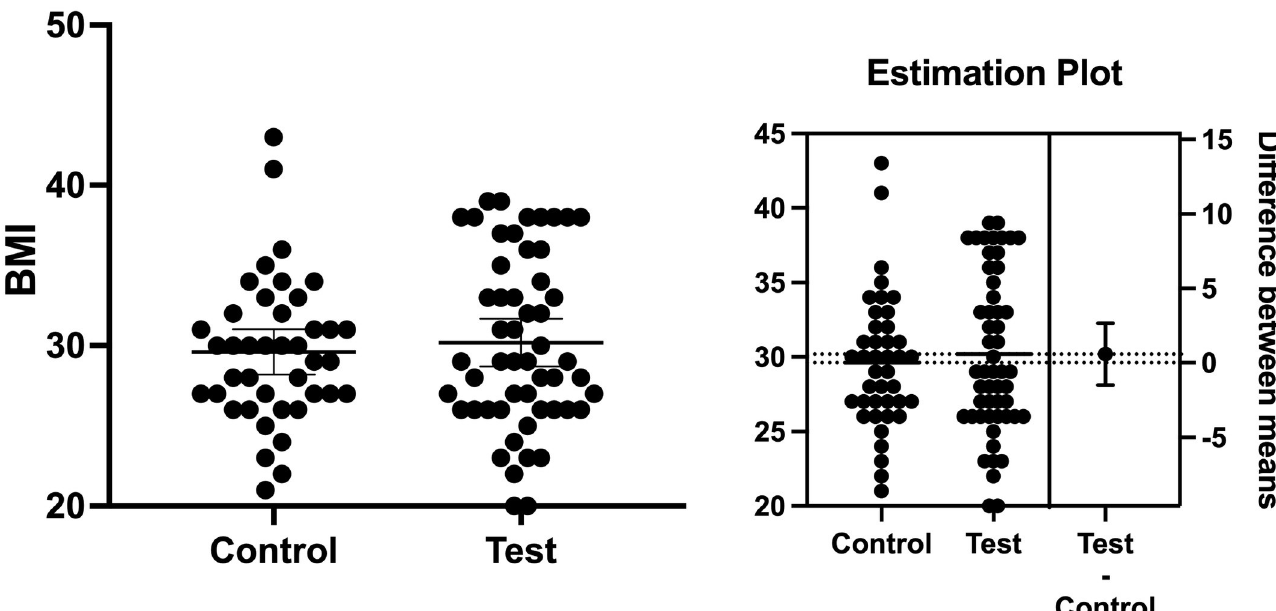
Fig 1. Body mass index (BMI). The mean BMI was 30.19 and 29.61 in the test and control groups, respectively. The mean difference between the groups was 0.57 ± 1.04 ( p = 0.58).